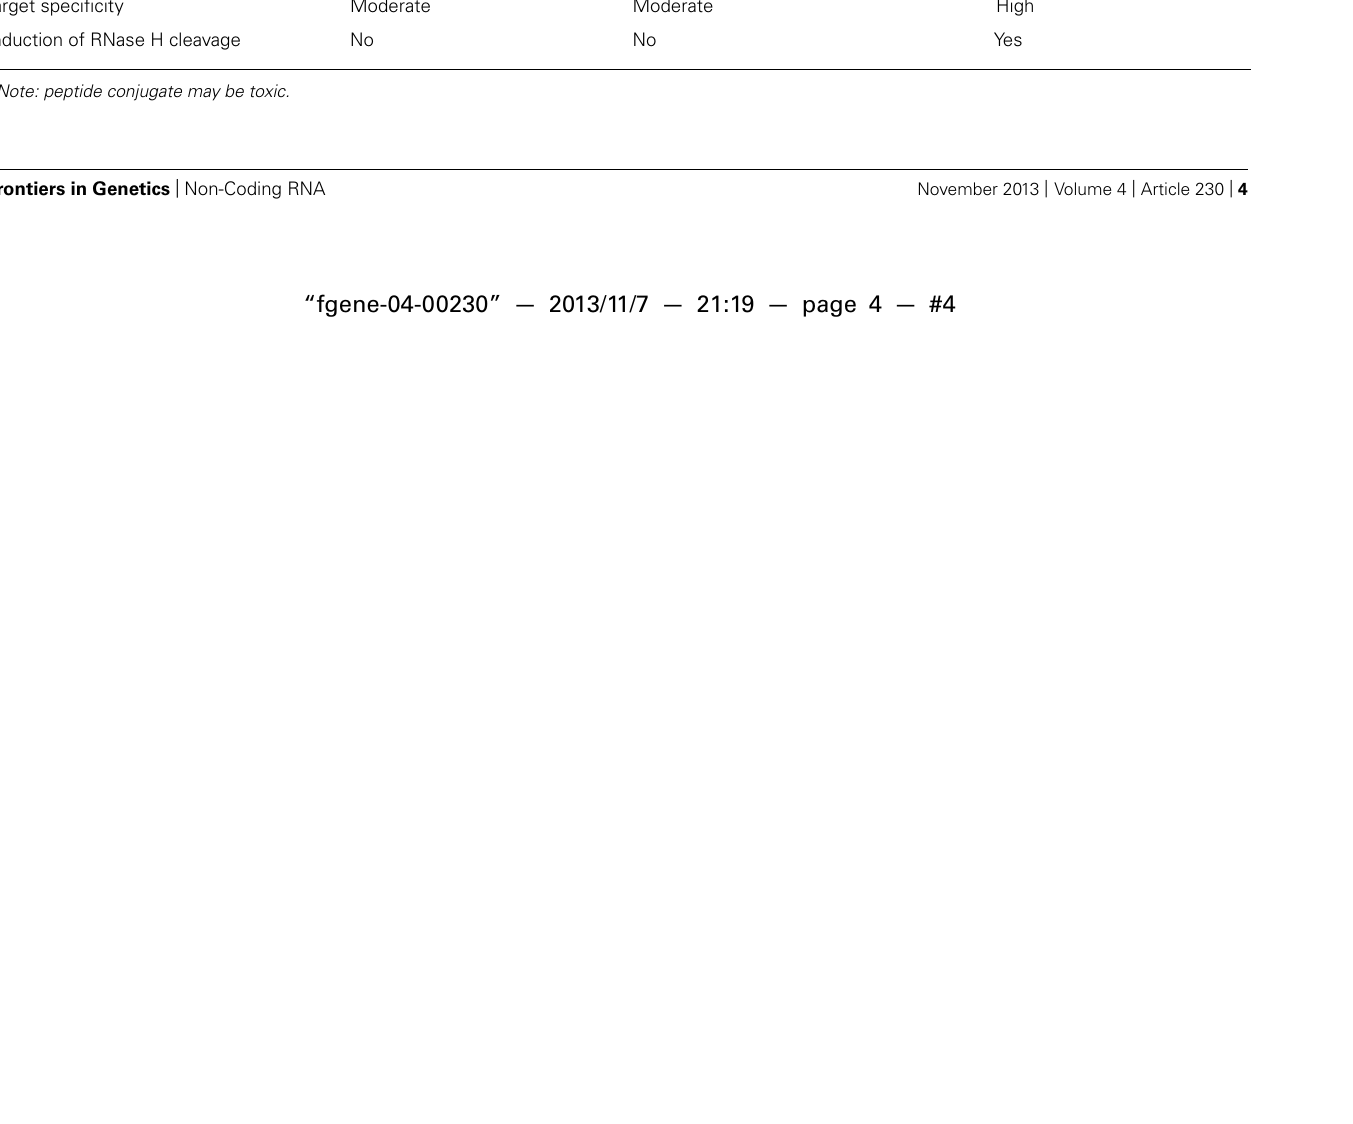
Induction of RNase H cleavage No No Yes *Note: peptide conjugate may be